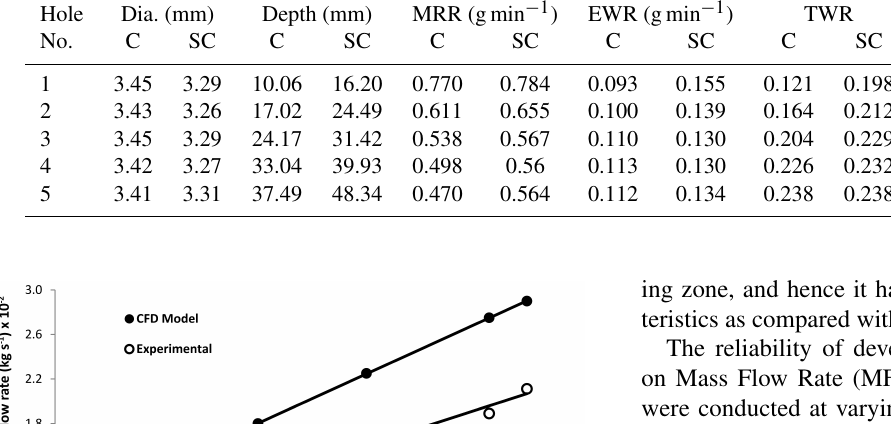
Table 4. Experimental results obtained by circular (C) and side-cut (SC) electrodes. Hole